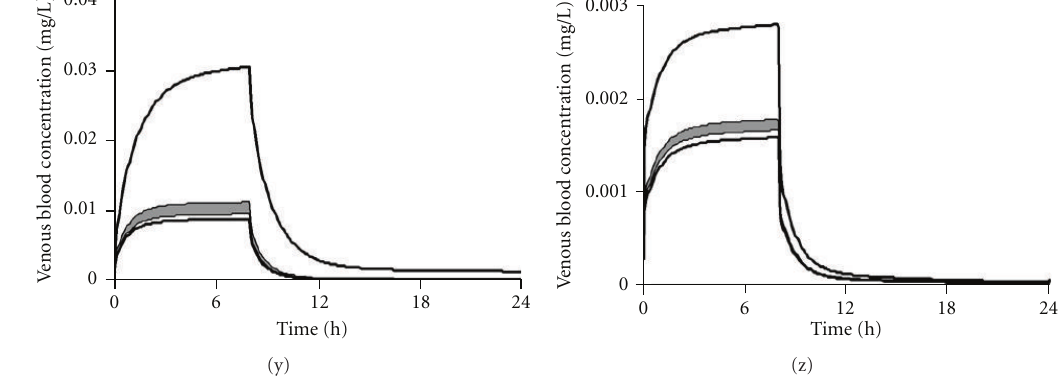
Figure 3: 24h simulation of the venous blood concentration following inhalation exposure to 1 ppm, 8 h for 26 volatile organic compounds considering maximum and minimum (bold lines) and QPPR-based hepatic extraction (grey area). (a) 1,1,1,2-Tetrachloroethane; (b) 1,1,2,2-tetrachloroethane; (c) 1,1,2-trichloroethane; (d) 1,1-dichloroethane; (e) 1,1-dichloroethylene; (f) 1,2-dichloroethane; (g) 1,2- dichloroethylene ( cis -); (h) benzene; (i) bromochloromethane; (j) bromodichloromethane; (k) carbon tetrachloride; (l) chloroethane; (m) chloroform; (n) dibromomethane; (o) dichloromethane; (p) ethylbenzene; (q) hexachloroethane; (r) isoprene; (s) methyl chloride; (t) m - xylene; (u) n -hexane; (v) pentachloroethane; (w) styrene; (x) toluene; (y) trichloroethylene; (z) vinyl chloride.